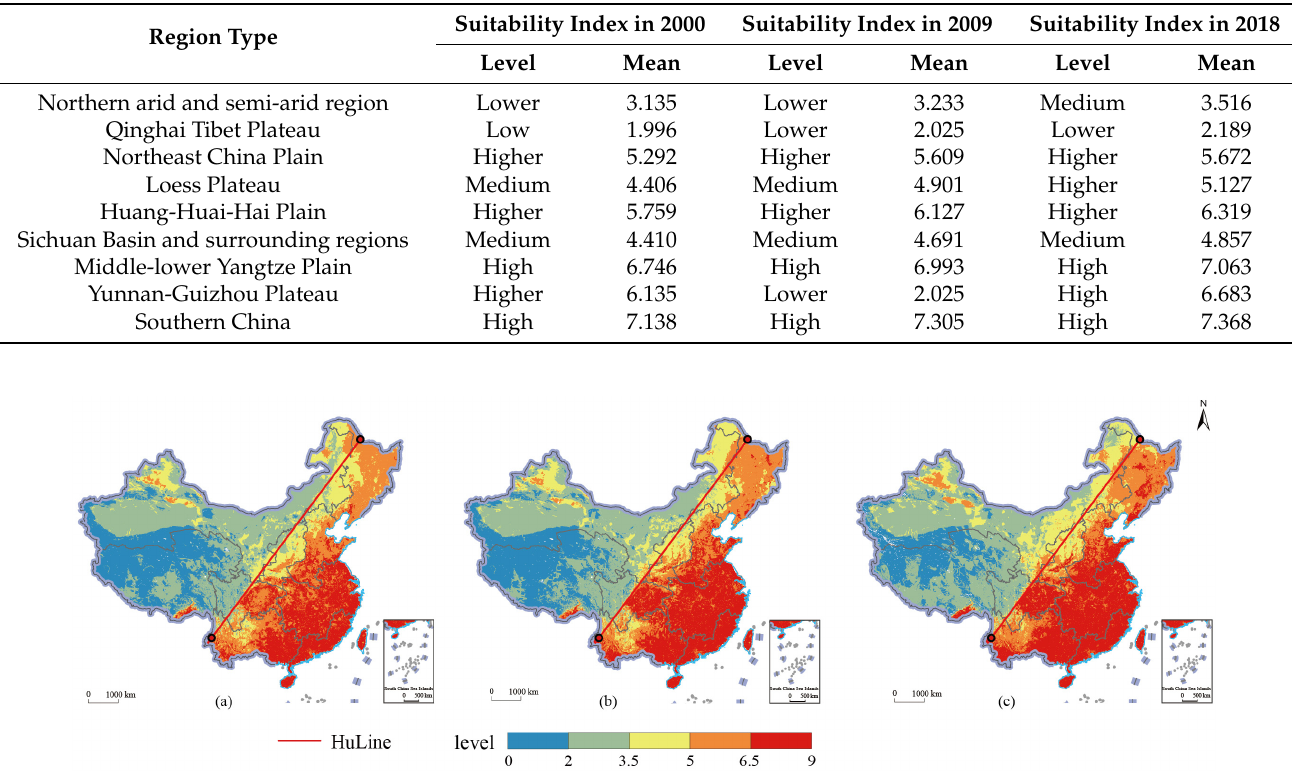
Table 4. Influencing factors and influencing factor detection of suitability level 1 indicators. q-Statistic